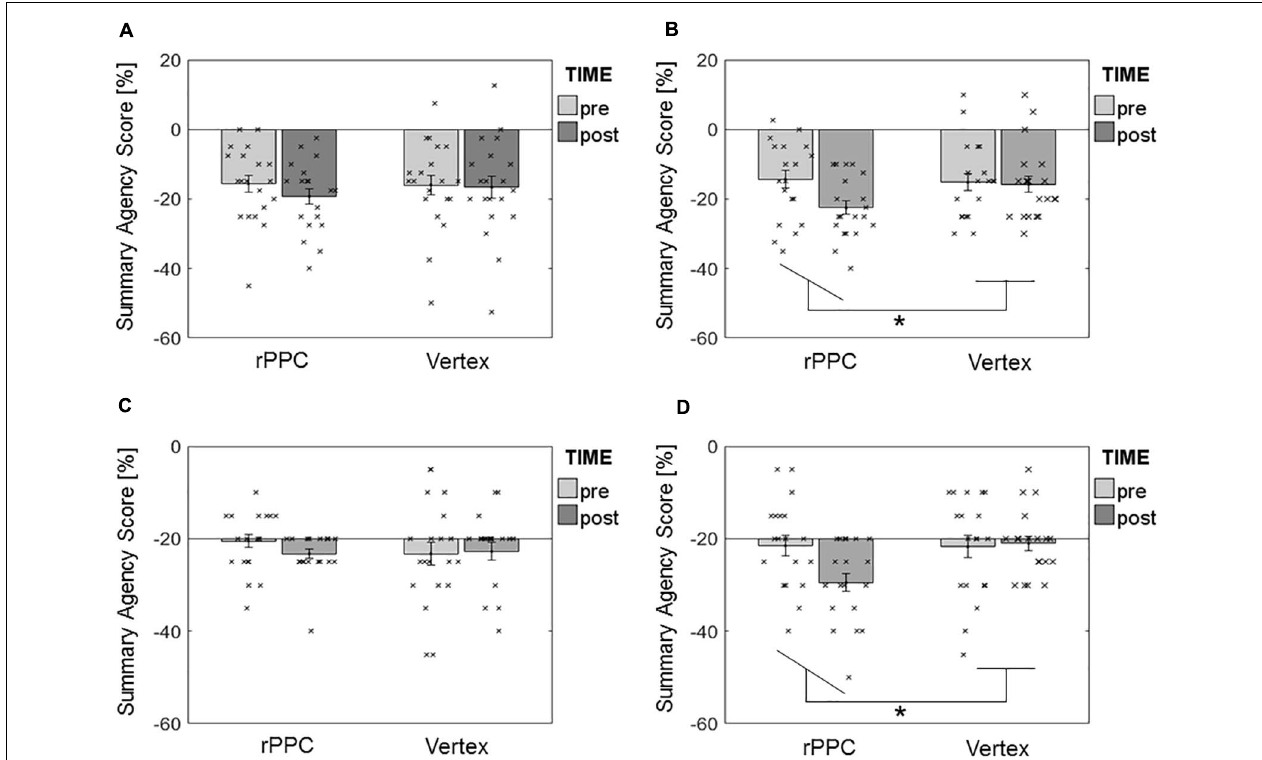
FIGURE 4 | Results of rmANOVA on the summary agency score during Turbulence. (A) 50-Hz protocol, Turbulence. (B) 30-Hz protocol, Turbulence. (C) 50-Hz protocol, Magic. (D) 30-Hz protocol, Magic. Bars represent mean values ± SE of the mean. Dots represent the single participants’ values. * Depicts significant STIMULATION × TIME